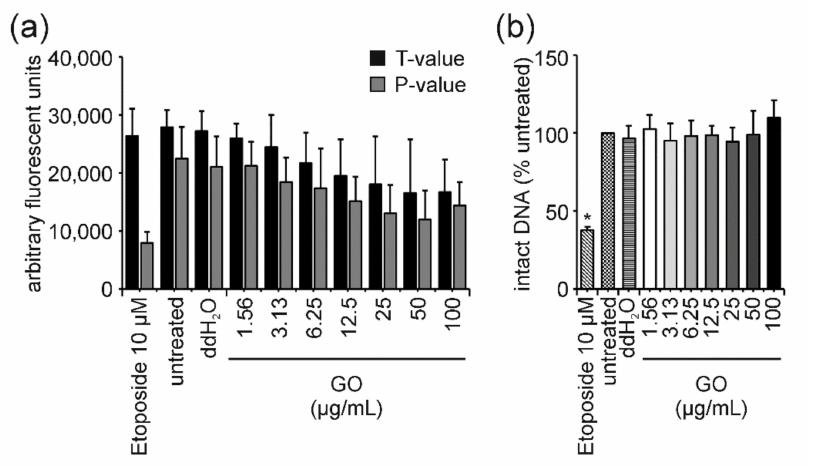
Figure 2. GO-induced interference and interference correction in the FADU assay after 3 h of incubation in Jurkat E6-I cells . Following 3 h exposure of Jurkat E6-I cells to GO, the FADU assay was performed and revealed a dose-dependent decrease in fluorescence of T- and p -values ( a ). After correction of the observed interference, no reduction in intact DNA was observed for any concentration of GO ( b ). Only incubation with 10 µ M etoposide for 30 min, which served as the positive control, induced genotoxic effects. Data shown represent the mean of three independent experiments and the corresponding standard deviation. (* p ≤